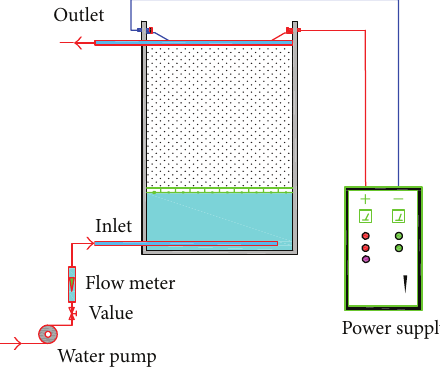
Figure 1: Experimental